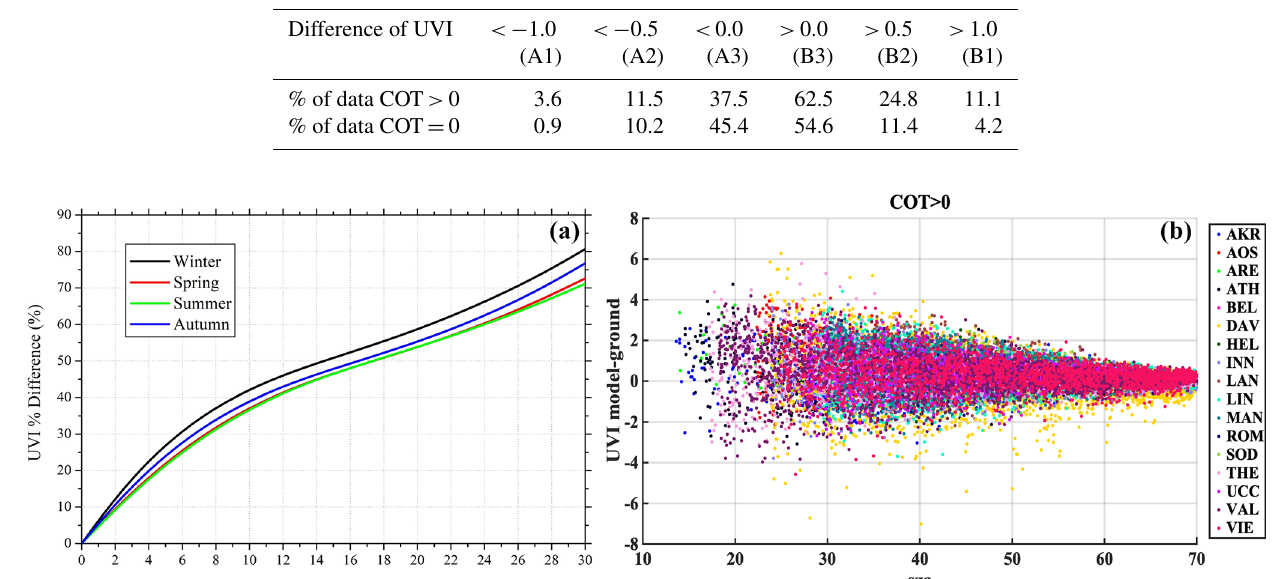
Table 6. Percentage of data for UVIOS underestimation (A1–A3) and overestimation (B1–B3) under clear- and cloudy-sky conditions for various UVI difference (modeled-ground) classes.